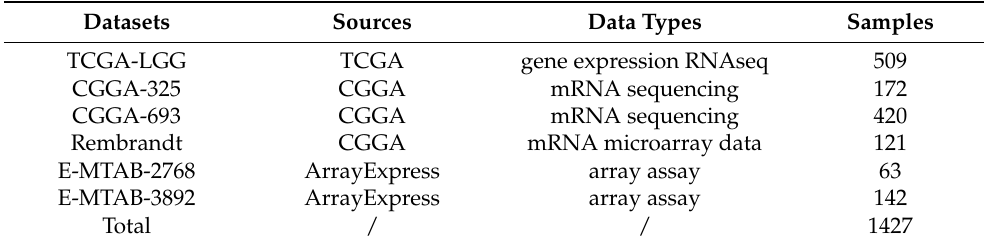
Table 1. The characteristic of data in this